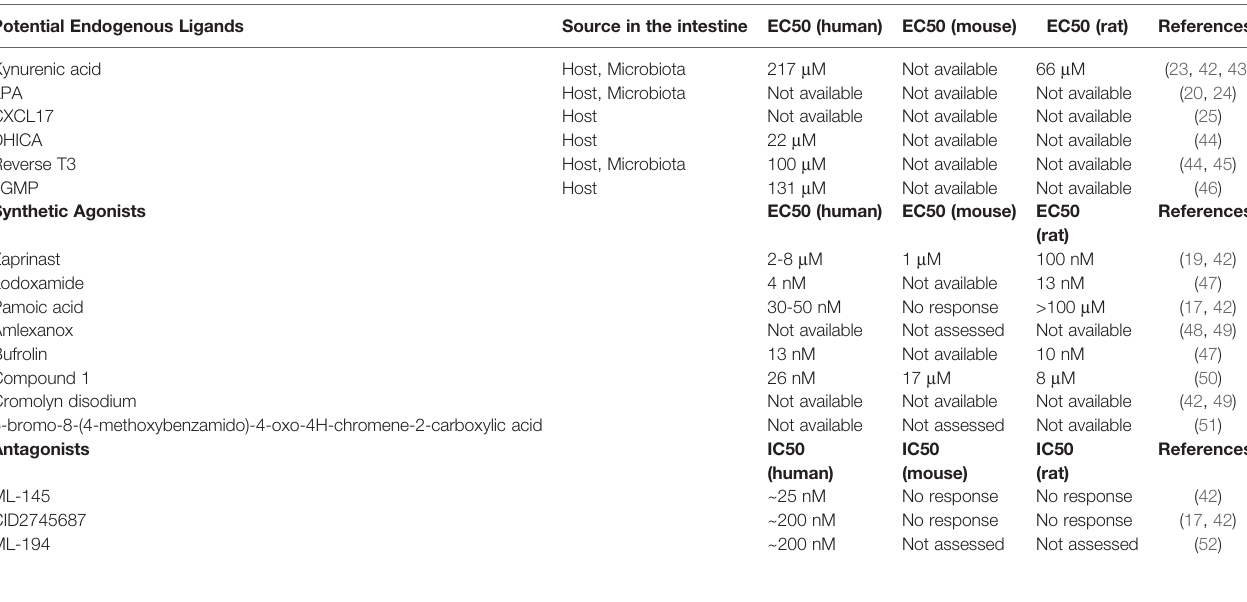
TABLE 1 | Proposed agonists and antagonists of